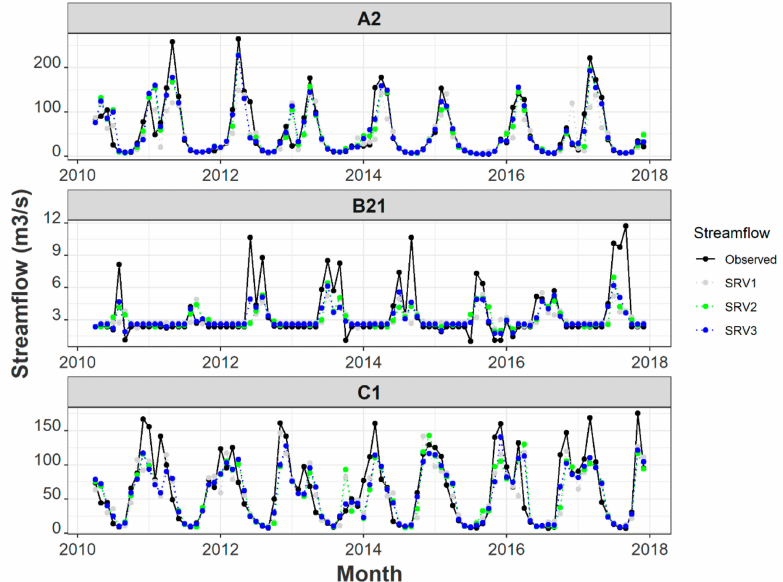
Figure 11. Comparison of observed and modeled streamflow for the large steady perennial ( A2 ), early intermittent ( B21 ), and early flashy perennial ( C1 )